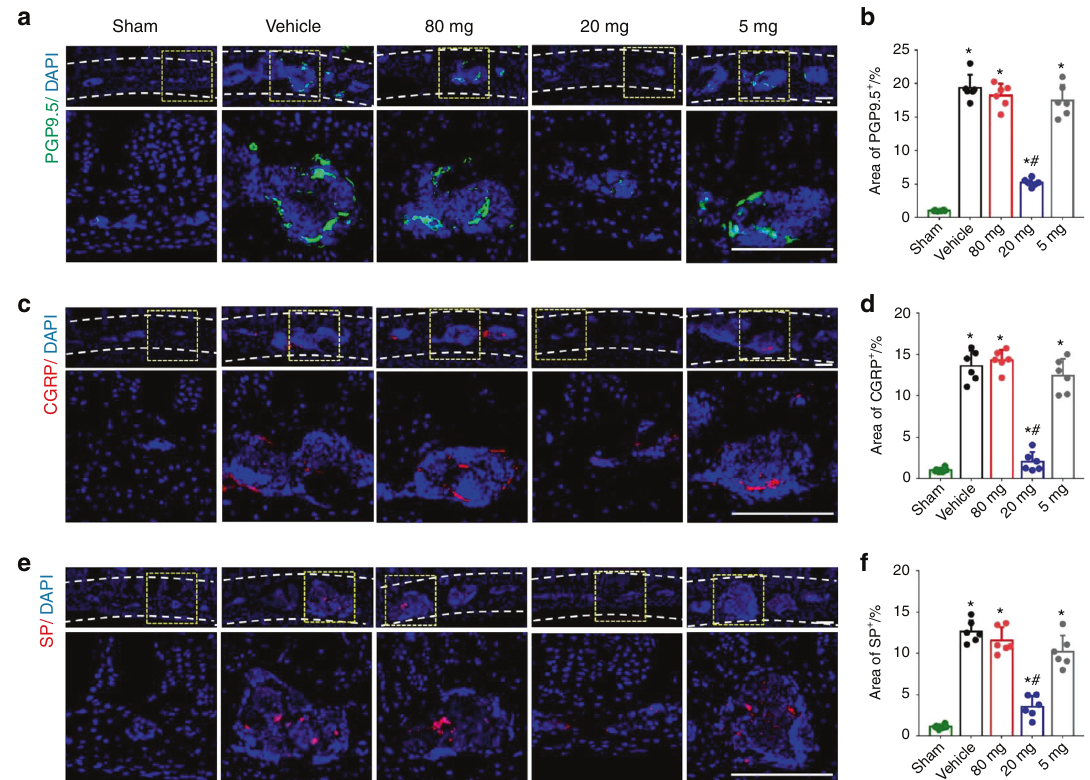
Fig. 8 Sensory innervation in the porous endplates was reduced by low-dose celecoxib. a Representative images of immunostaining of PGP9.5 (green) and DAPI (blue) of nerve fi bers in the lumbar endplates at 4 weeks after the discontinuation of celecoxib or vehicle treatment. b Quantitative analysis of the percentage of PGP9.5 + area in lumbar endplates. c Representative images of immunostaining of CGRP (red) and DAPI (blue) of nerve fi bers in the lumbar endplates at 4 weeks after the discontinuation of celecoxib or vehicle treatment. d Quantitative analysis of the percentage of CGRP + area in lumbar endplates. e Representative images of immunostaining of SP (red) and DAPI (blue) in the lumbar endplates at 4 weeks after the discontinuation of celecoxib or vehicle treatment. f Quantitative analysis of the percentage of SP + area in lumbar endplates. Scale bars, 50 μ m ( a, c, e ) * P < 0.05 compared with the sham group and # P < 0.05 com p ared with the vehicle group at the corresponding time points. n = 6 per group ( b, d, f